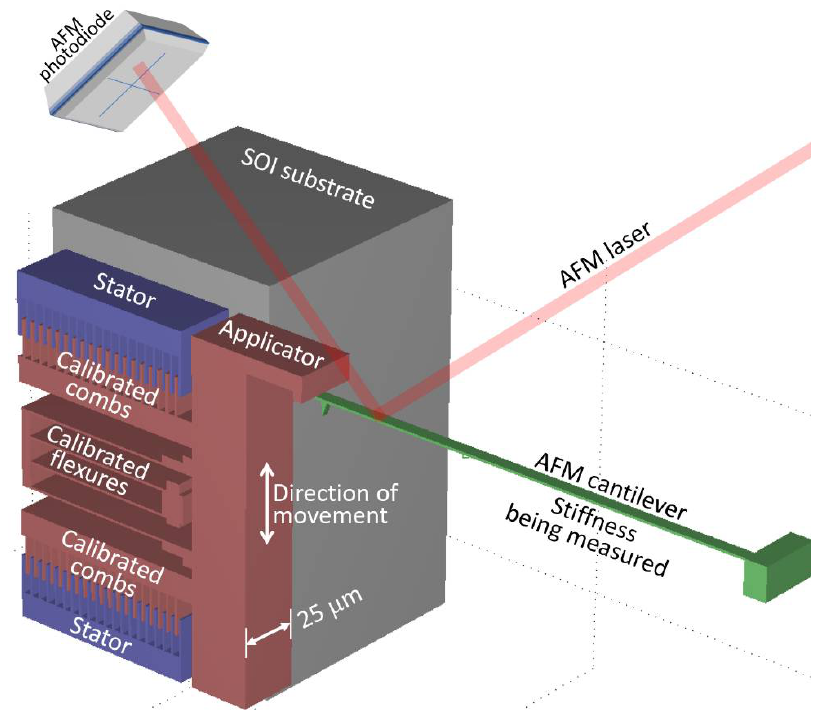
Figure 4. Illustration of AFM calibration. A calibrated MEMS is used to measure the stiffness of